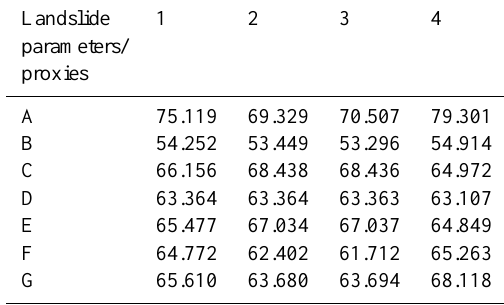
Table 3. Table of area under curve (AUC) values of landslide area and landslide